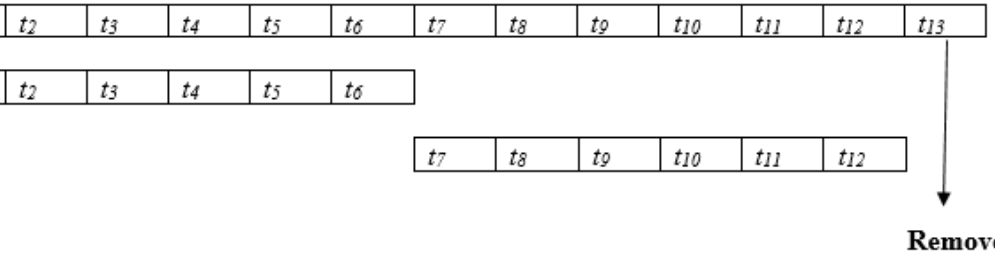
Figure 2. The timeline of the images of a patient who went through thirteen visual field tests. The visual field test times are specified in the timeline and are utilized in training, and those in the black timeline are utilized in the prediction.